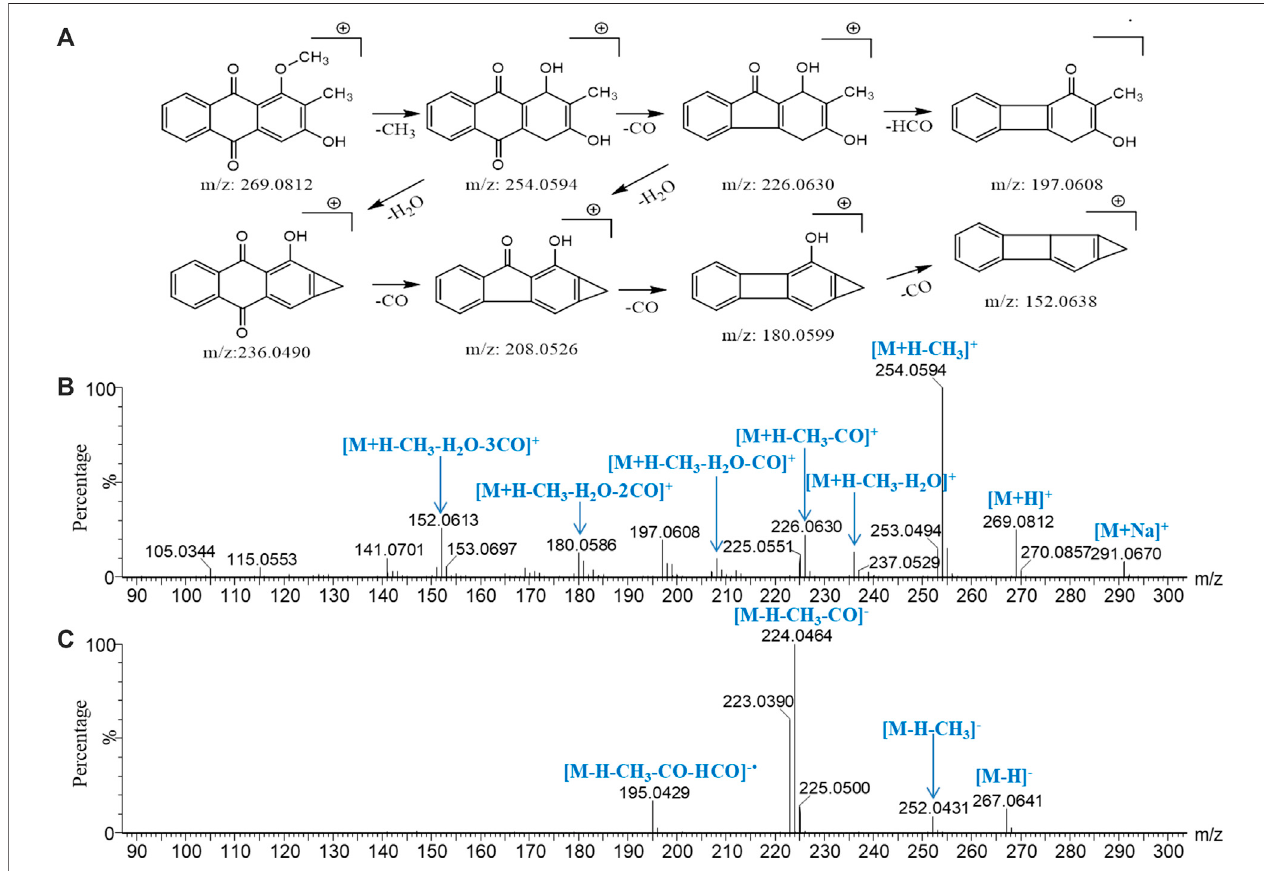
FIGURE 7 | Major cleavage pathway (A) and mass spectrogram of rubiadin-1-methyl ether at high energy in positive ion mode (B) and in negative ion mode (C) .